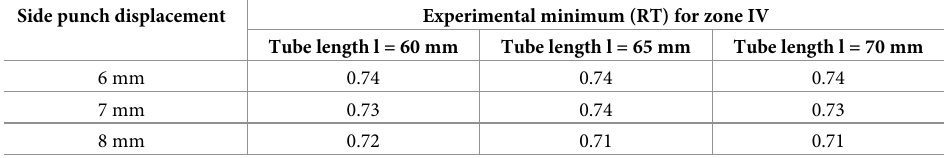
Table 4. Experimental results for minimum RT in zone IV.